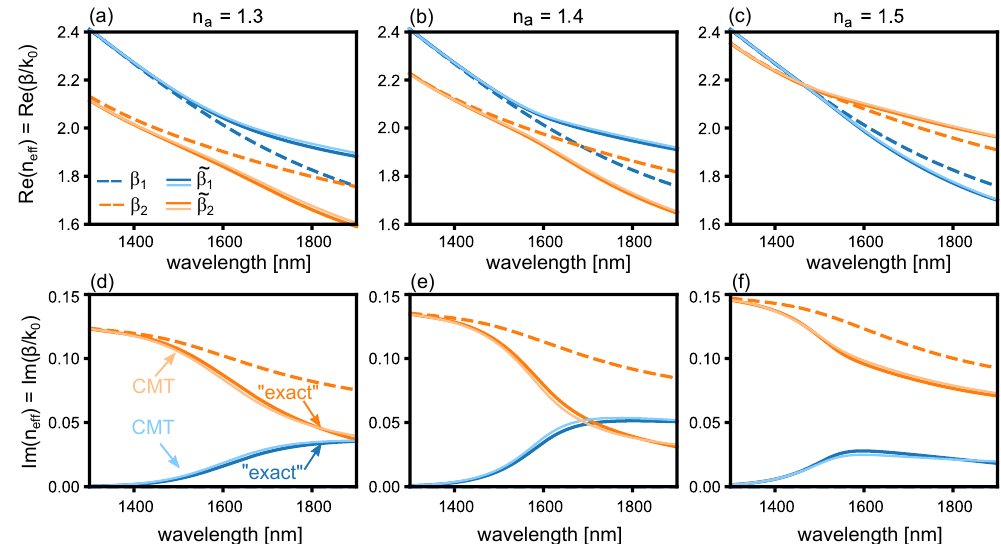
Figure 4. Real part of the effective index (cid:60) e ( n eff ) = (cid:60) e ( β / k 0 ) as a function of wavelength for the geometry shown in Figure 2 when ( a ) n a = 1.3, ( b ) n a = 1.4, ( c ) n a = 1.5, using the lossy Drude model for the gold permittivity. The dashed line shows the isolated plasmonic- and dielectric- modes, respectively. The solid lines show the hybrid eigenmodes according to the “exact” solution (dark) and obtained from CMT via the eigenvalues of Equation (9) (light). ( d – f ) show the associated (cid:61) m ( n eff )